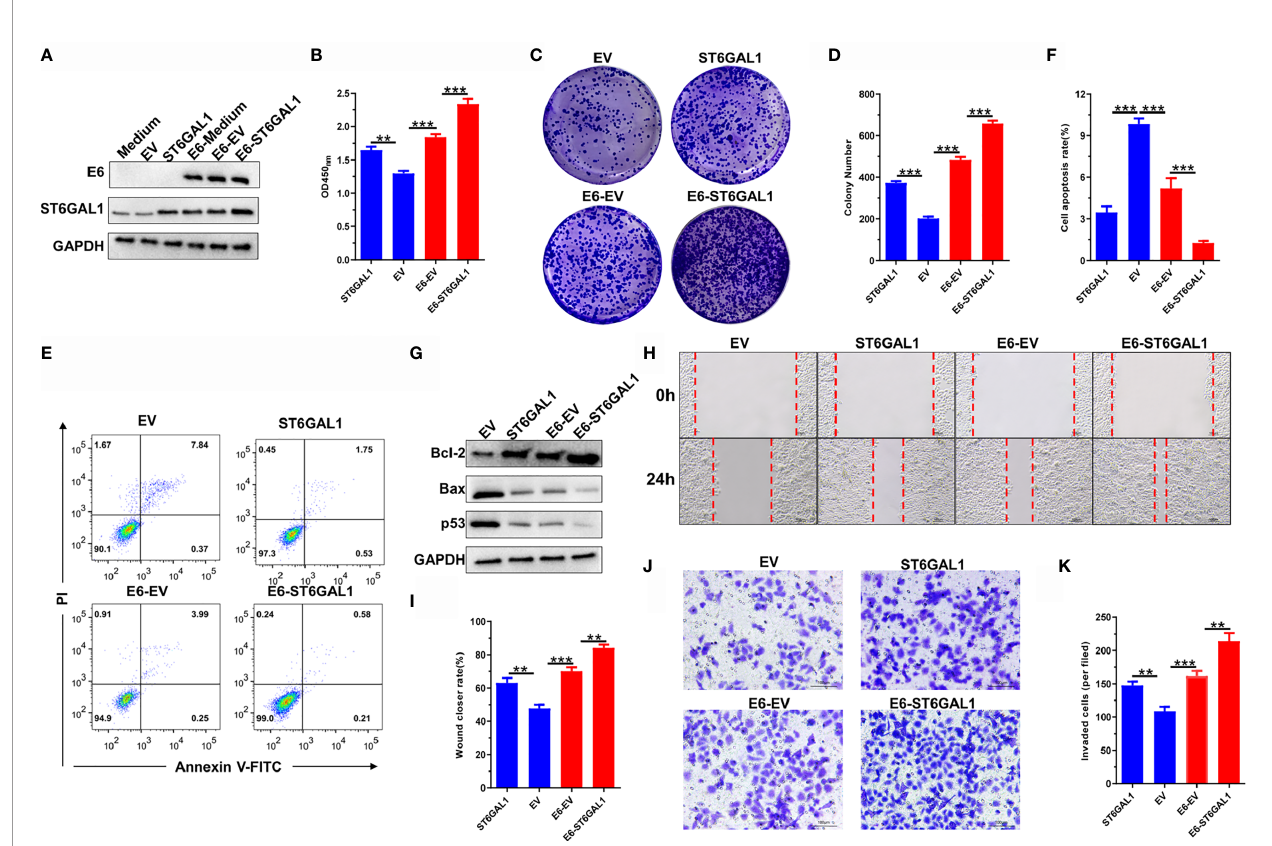
FIGURE 3 | ST6GAL1 promotes oncogenic activities in both E6-positive and E6-negative cervical cancer cells. (A) C33A and C33A-E6 (E6 stable expressing) cells were transiently transfected with pcDNA3.1-ST6GAL1 overexpressing plasmid (ST6GAL1) or empty vector (EV). Then, protein expression of E6 and ST6GAL1 were detected by Western blot. (B) Proliferation of indicated cells were detected by CCK-8 assay. (C) The clones of indicated cells were visualized by crystal violet staining. (D) Statistical analysis of colony numbers in C33A and C33A-E6 cells. (E, F) Apoptosis of indicated cells were detected by fl ow cytometry, and then, apoptotic rates were statistically analyzed. (G) Western blot was used to detect the expression of apoptosis-related proteins. (H, I) Migrative abilities of indicated cells were detected by wound-healing assay and statistically analyzed. (J, K) Invasive abilities of indicated cells were detected by Transwell assay and statistically analyzed. Data were presented as mean ± SD from the three independent replicates. ** p < 0.01; *** p <